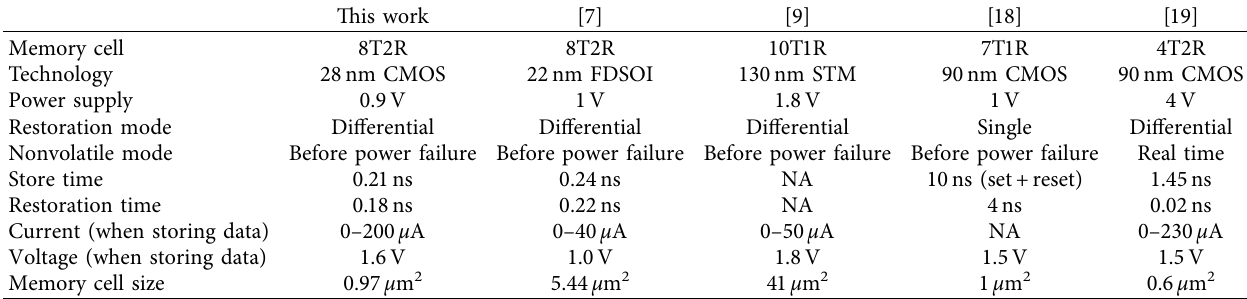
Table 3: Performance comparison of diferent nvSRAM memory